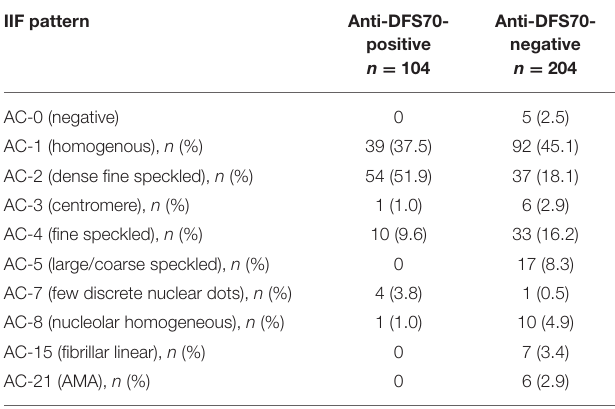
TABLE 3 | Agreement between IIF pattern (Hep2-cells) and anti-DFS70 antibodies in immunoblot. IIF